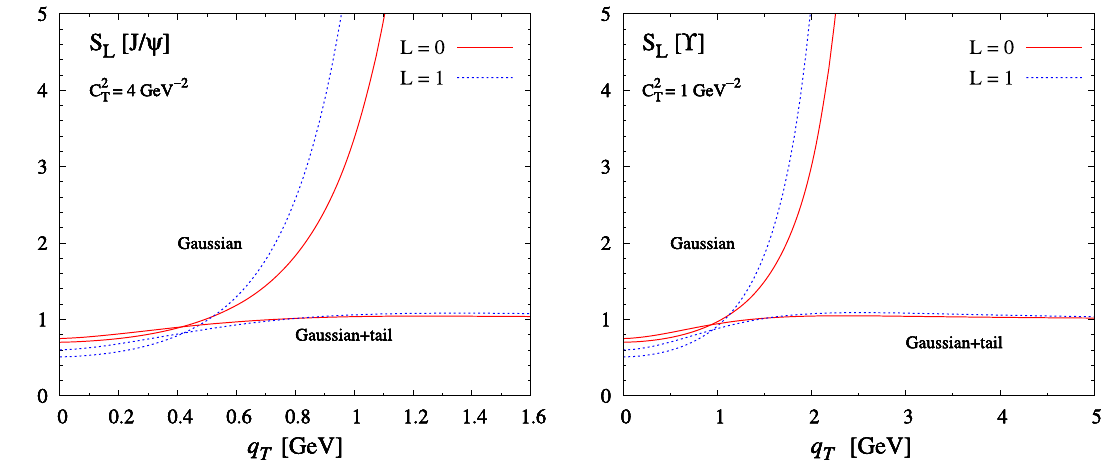
Fig. 2 Transverse momentum dependence of the smearing functions S L , with L = 0 , 1, for e p → e (cid:5) J /ψ X (left panel) and e p → e (cid:5) ϒ X (right panel), for the adopted model parameterizations for the gluon TMD and (cid:21) L with the choices C 2 ( ϒ production) Table 1 Numerical values of the LDMEs for J /ψ production